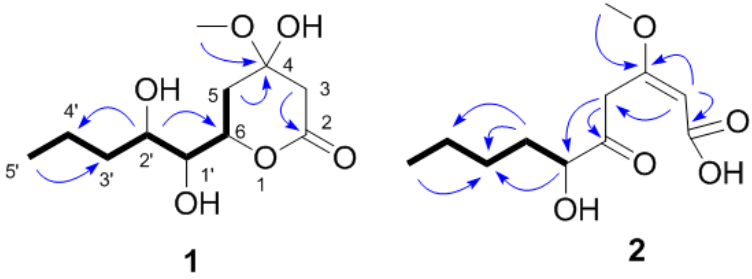
Figure 2. Selected 1 H – 1 H COSY ( ) and HMBC ( → ) correlations of 1 and 2 .